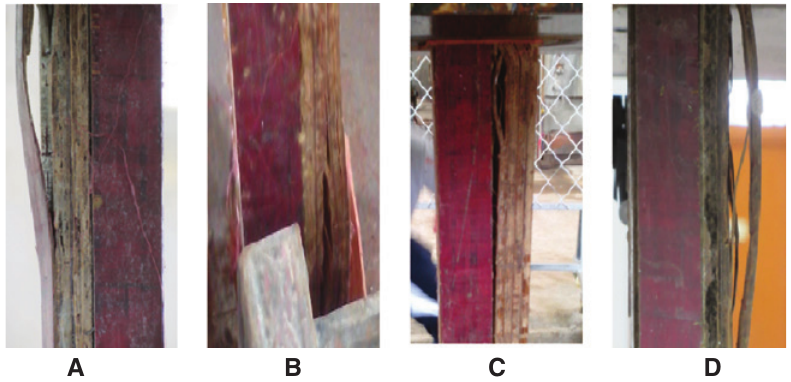
Figure 9: Glue failure between the matrixes at the end of the column. (A) Z9, (B) Z12, (C) ZP19, and (D) ZP20.